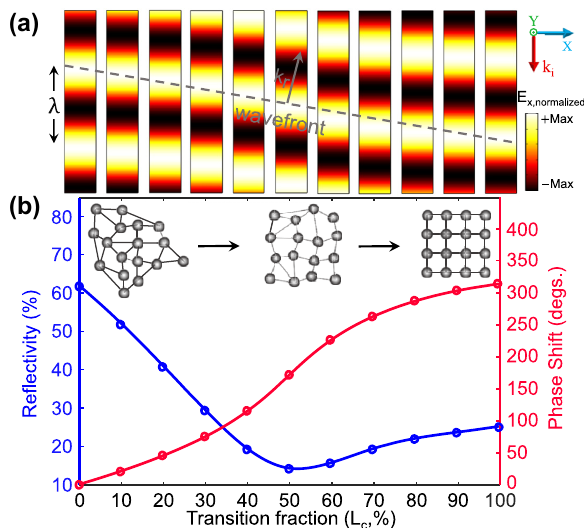
Figure 4: Amplitude and phase evolution of the hybrid meta-atom in Figure 1 upon conversion from the amorphous to the crystalline state. (a) Normalized reflected E x field patterns from the metasurface in Figure 1 for eleven GST crystallization states (i.e., amorphous (leftmost), fully crystalline (rightmost), and 9 intermediate states separated by 10 % crystallization from each other). Each pattern is calculated by an independent full-wave numerical simulation under the illumination of a normally x -polarized plane wave with 𝜆 = 1550 nm (see Figure 1). The gray dashed line defining the wavefront verifies the achievable total phase shift of 315 ◦ . (b) Evolution of reflection amplitude (left axis) and phase shift (right axis) as a function of the GST crystallization fraction. Inset: conceptual schematic depicts the gradual nonvolatile phase transition of GST from amorphous (left) to fully crystalline (right). All design parameters are the same as those in the caption of Figure 1.